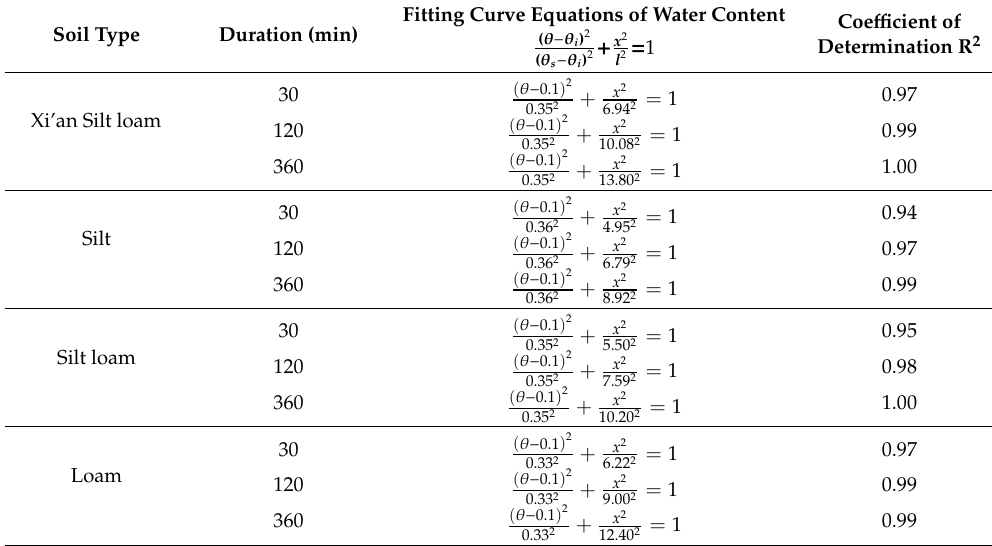
Figure 7. Water content distribution of the wetting body radius at different durations simulated by HYDRUS: ( a ) Xi’an silt loam; ( b ) Silt; ( c ) Silt loam; ( d ) Loam. Table 3. Fitting results of water content distribution curve of wetting the body radius.